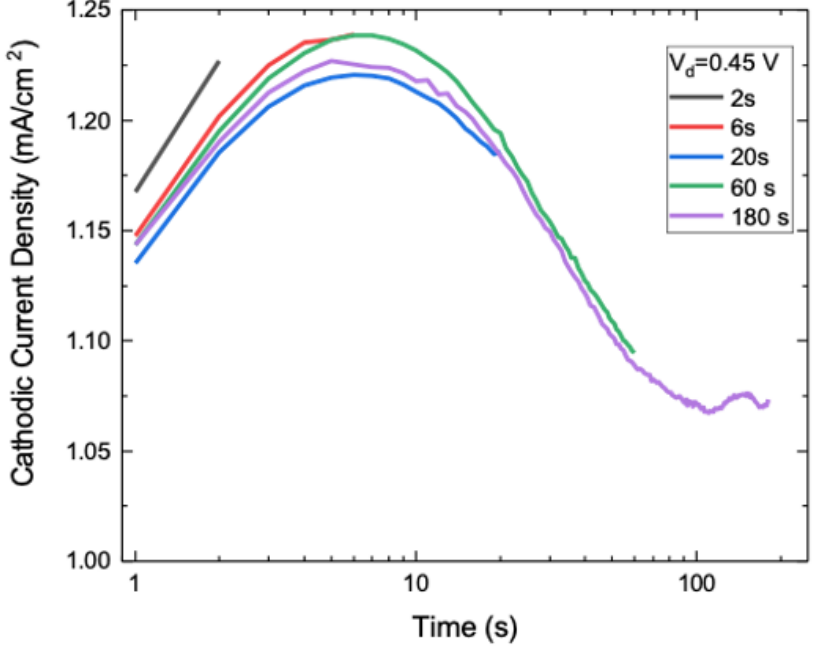
Figure 5. Current transients recorded during the samples electrodeposition at V d = 0.45 V.